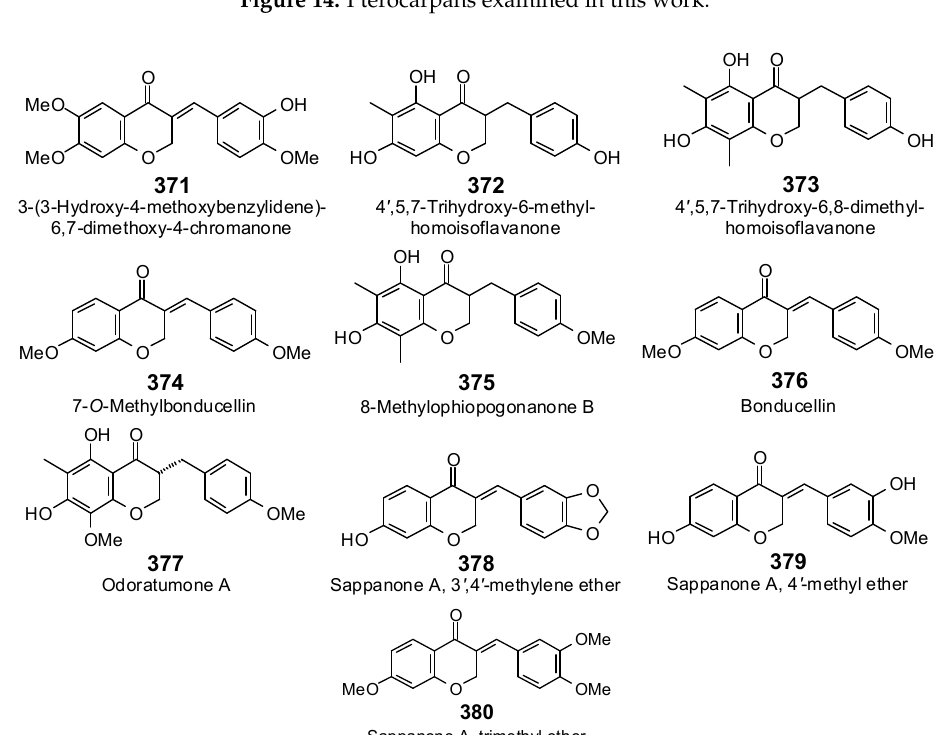
Figure 15. Chromones examined in this work.